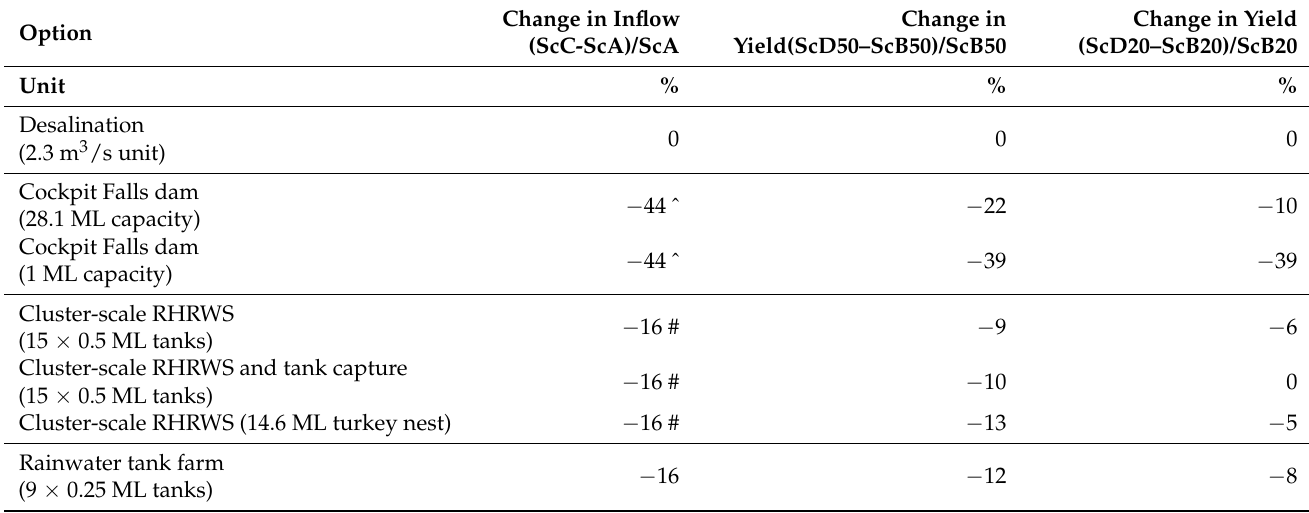
Table 8. Percentage change in inflows and yield under a drier future